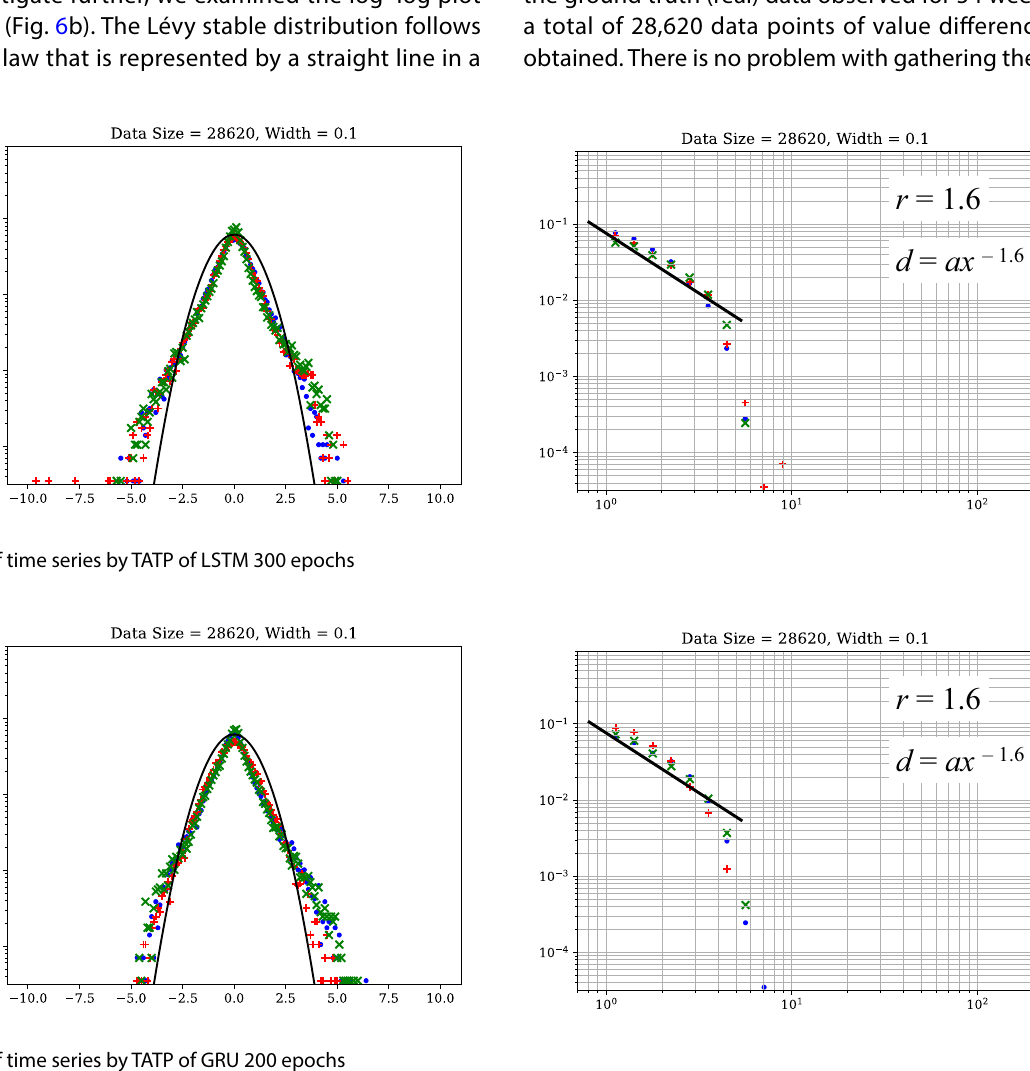
Fig. 8 PDF of time series by TATP of GRU 200